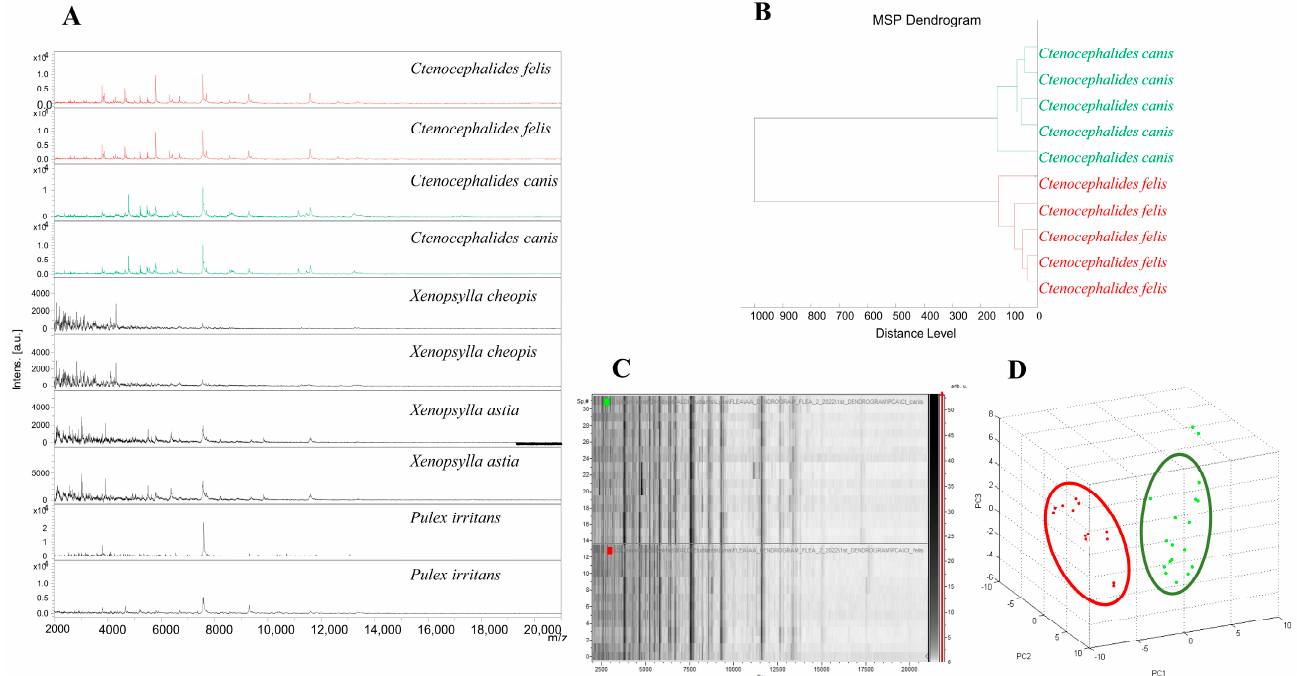
Figure 2. Building the database using comparison of MS spectra obtained from diverse flea species. Spectral alignment of five flea species using flexAnalysis software to show discriminative peaks; representative MALDI-TOF MS spectra from the cephalothorax of X. cheopis , X. astia , and P. irritans with low-intensity MS profiles and high background noise; representative MS spectra of C. canis and C. felis with high-quality spectra (peak intensity >3000 arbitrary units (a.u.), no background noise with baseline subtracted ( A ). Dendrogram of MALDI-TOF MS spectra of flea species collected in Vietnam. Biotyper software v.3.0 was used for cluster analysis ( B ). As confirmed with PCA, the MS spectra